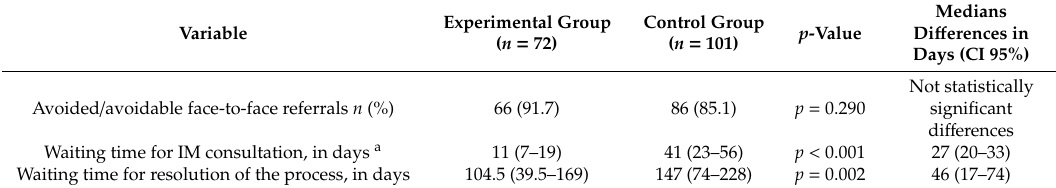
Table 4. Summary and di ff erences between groups of the dependent